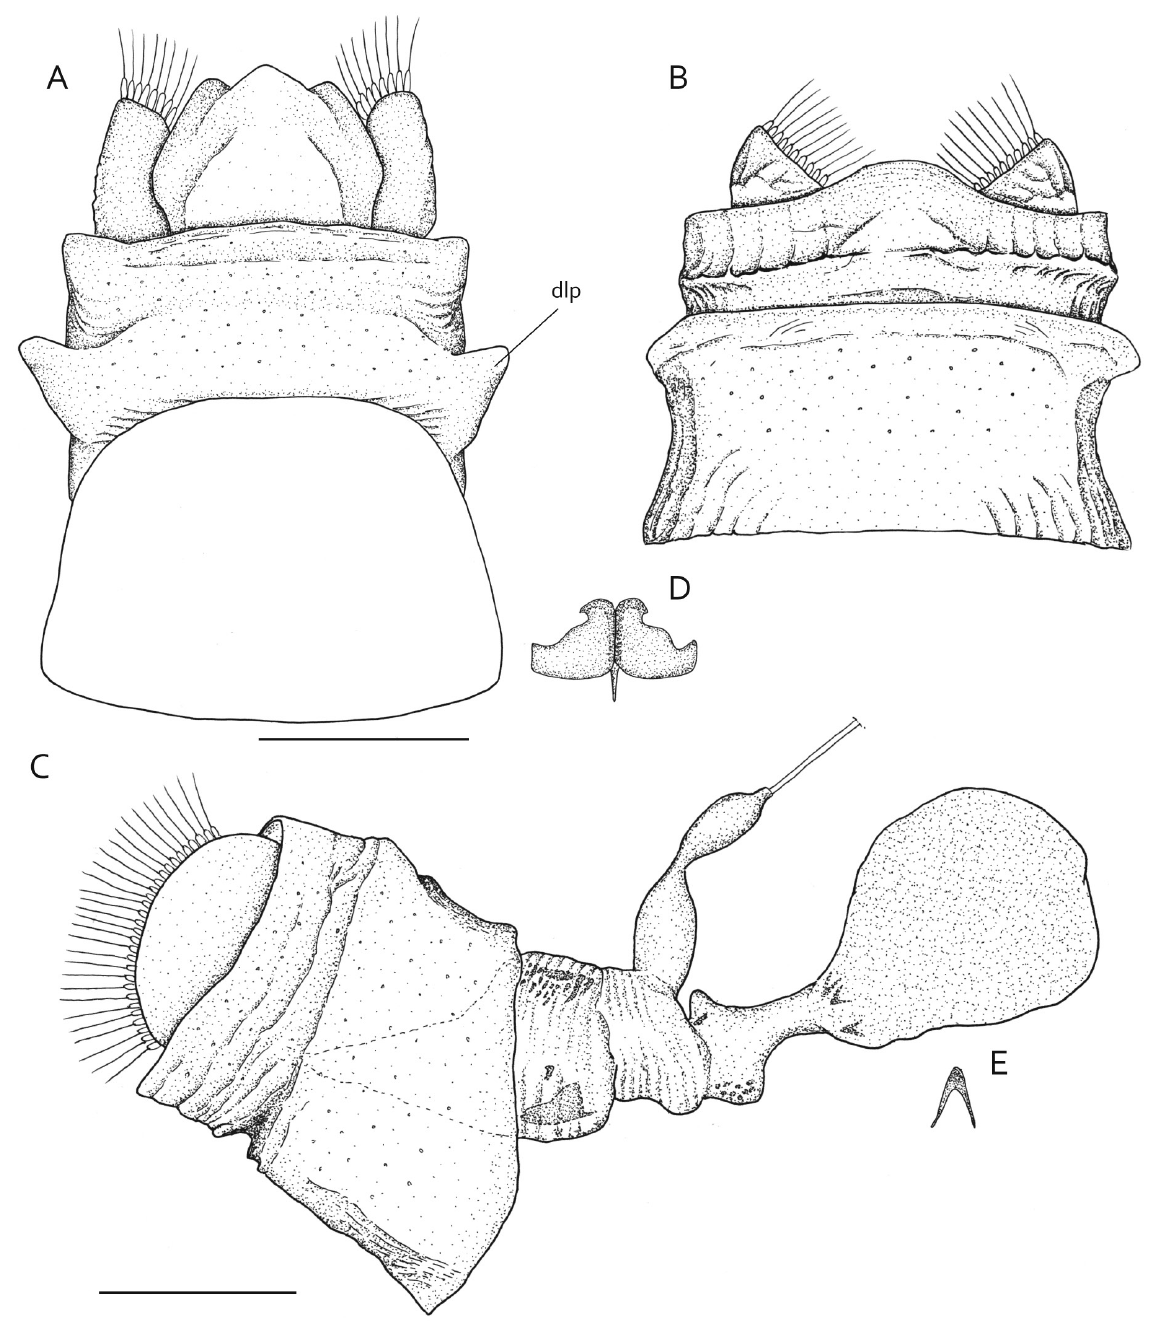
Figure 13. Female genitalia of Issikiomartyria catapasta sp. n. [paratype]. A: genitalia capsule, dorsal view; B: ditto, ventral view; C: female genitalia, lateral view; D: genital sclerite; E: signa. Abbreviation: dlp = dorso-lateral protrusion. Scale bars: 0.2 mm.